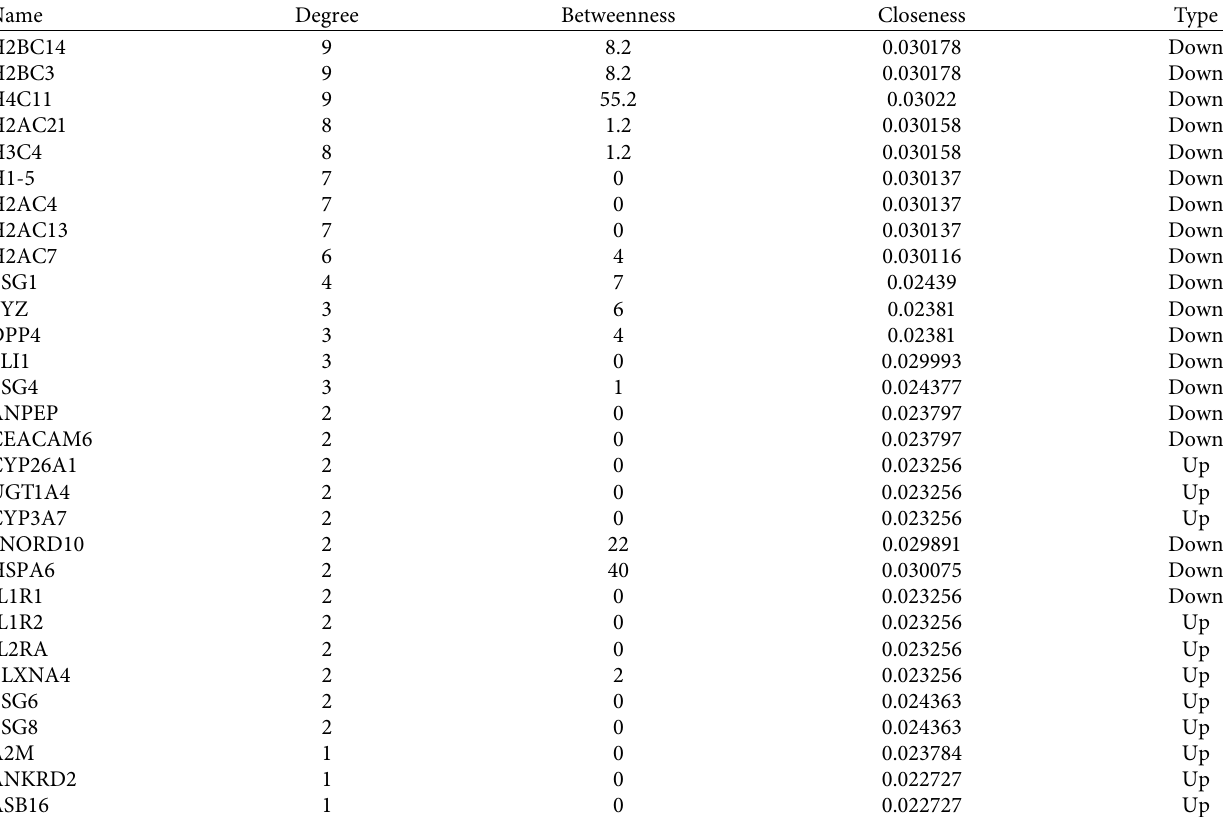
Table 2: Degree of nodes in the protein-protein interaction